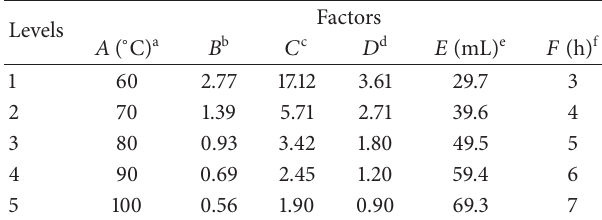
Table 1: Levels and factors affecting the fluid-loss properties.